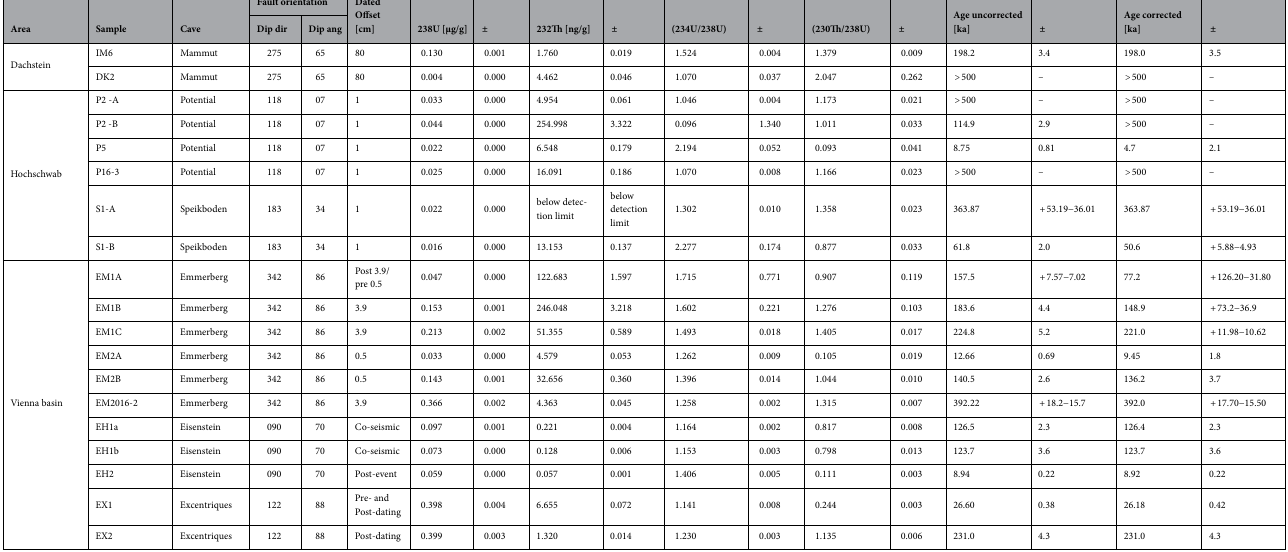
Table 1. 230 Th/U dating results for cave speleothems from the Northern Calcareous Alps (Austria).